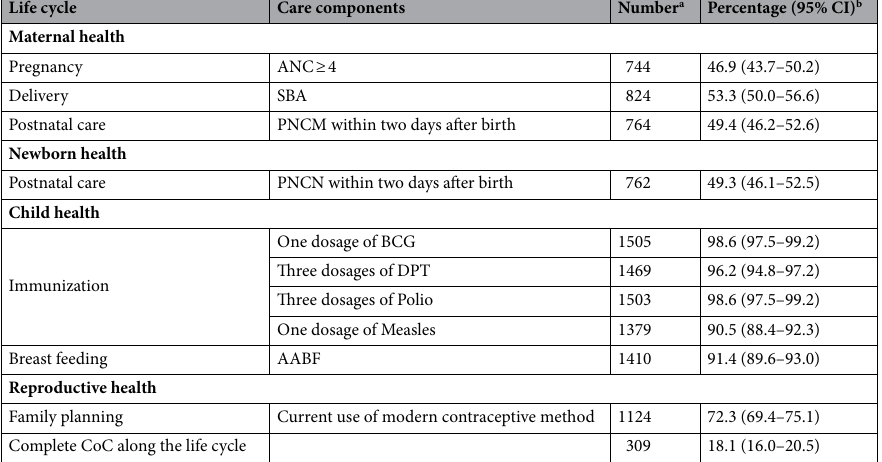
Table 2. Percent distribution of MNCH care coverage and CoC achievement: Bangladesh Demography and Health Survey 2017–2018 (n = 1527). CI = confidence interval. a Numbers are unweighted; b Percentages are weighted.